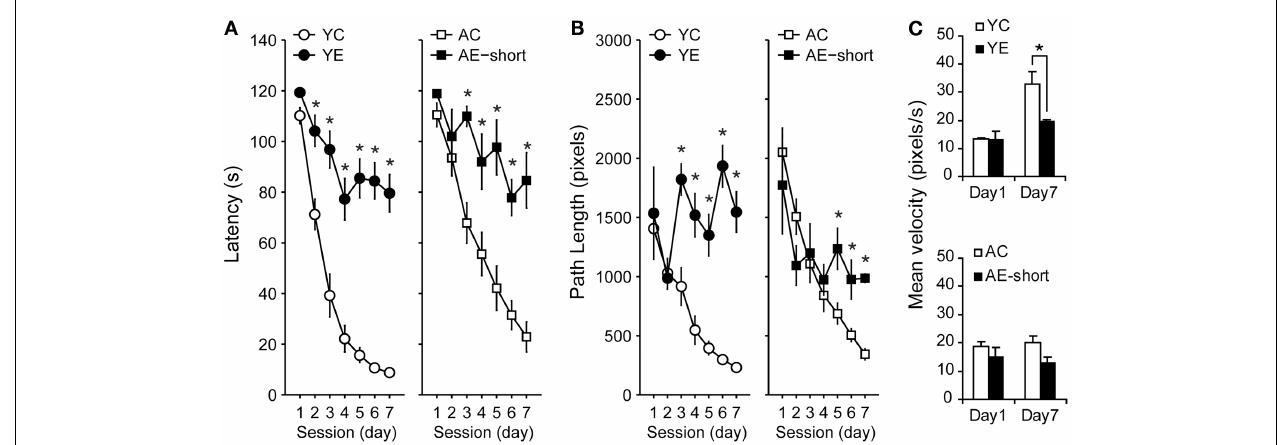
the first 4days, aged-matched controls improved monotonically during all training days. (B) Average path length as in (A) .The abscissa in (A,B) show training days; the ordinate shows the average time taken to reach the platform and path length, respectively, on four trials on each day. (C) Averaged speed velocity in the first (Day 1) and last (Day 7) days of training.YC, young control;YE, young epileptic; AC, aged control; AE-short, aged with status epilepticus at 18months of age. * P < 0.05 compared to aged-matched controls (Student Newman–Keuls post hoc